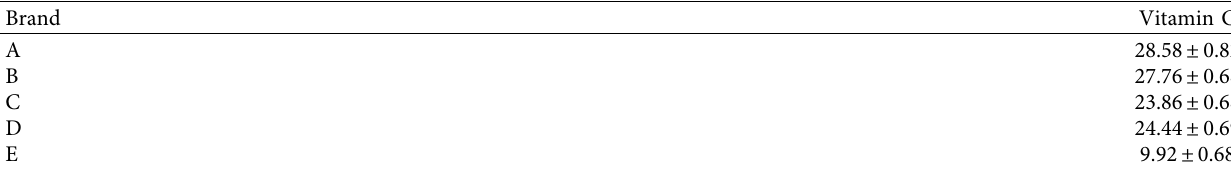
Table 3: Vitamin C content in mg/100g (average ± standard deviation).